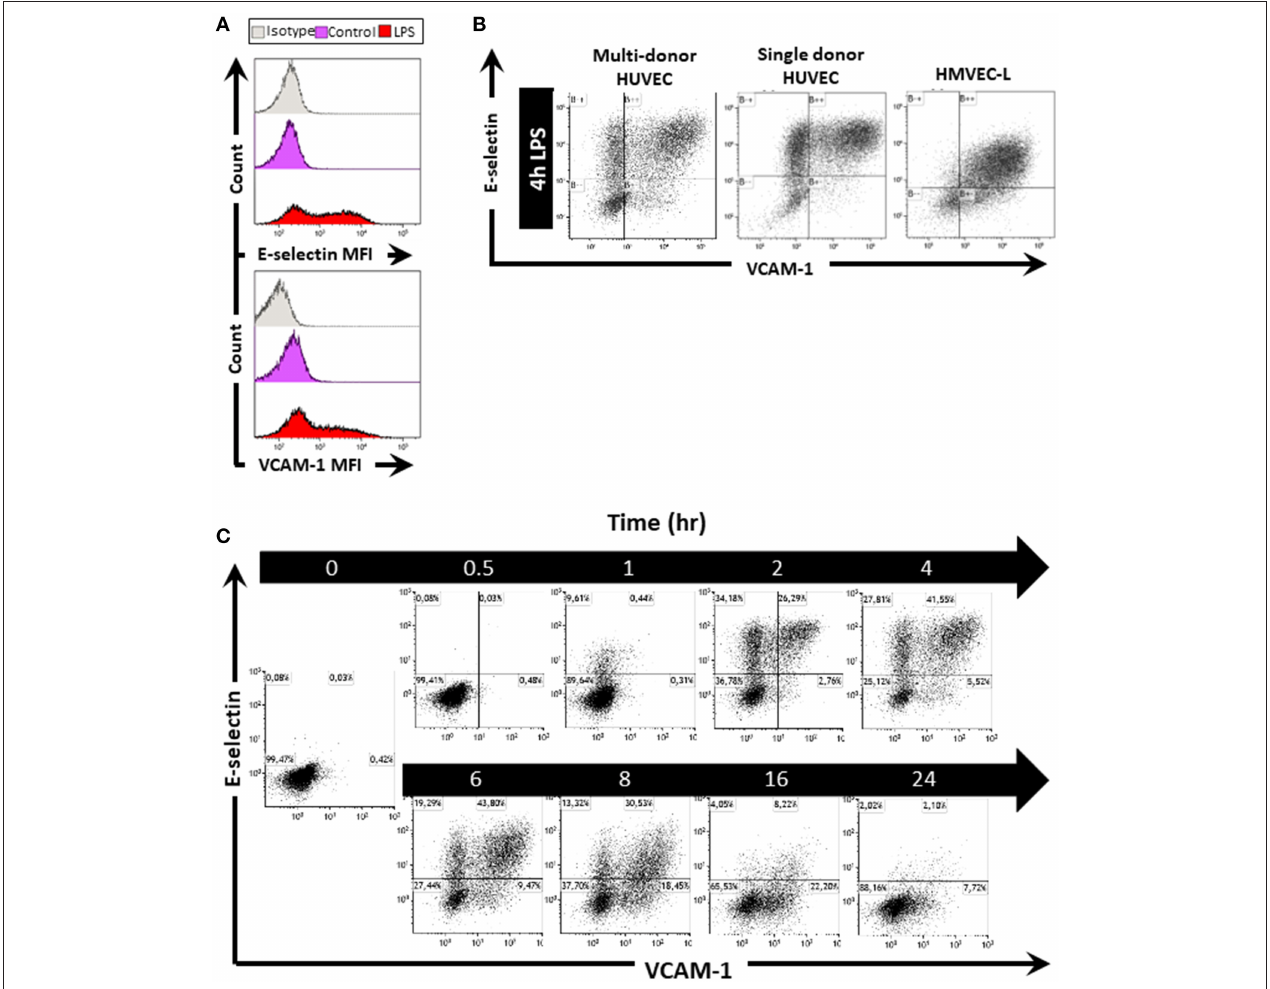
FIGURE 2 | LPS stimulation of endothelial cells in vitro induces the formation of EC subpopulations based on E-selectin and VCAM-1 expression. (A) Histograms of HUVEC as one whole population show the mean fluorescent intensity (MFI) of E-selectin and VCAM-1 in untreated control and EC treated with LPS for 4h. Isotype controls were also included. (B) Scatterplots of EC subpopulations based on E-selectin and VCAM-1 expression in multi-donor HUVEC, single donor HUVEC, and lung microvascular endothelium (HMVEC-L), 4h after LPS exposure. The data shown is representative of at least four independent experiments. (C) Kinetics of EC subpopulation formation based on E-selectin and VCAM-1 expression in HUVEC stimulated with LPS for the indicated time periods. The data shown is representative of two independent